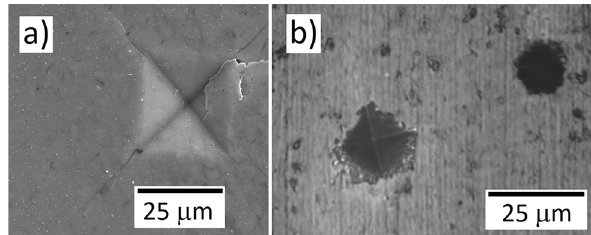
Figure 11: Representative images of residual hardness impressions on the cross - section of the HA extrudate ( a ) at the head zone ( RD of 99% ) and ( b ) at the extruded zone with RD of